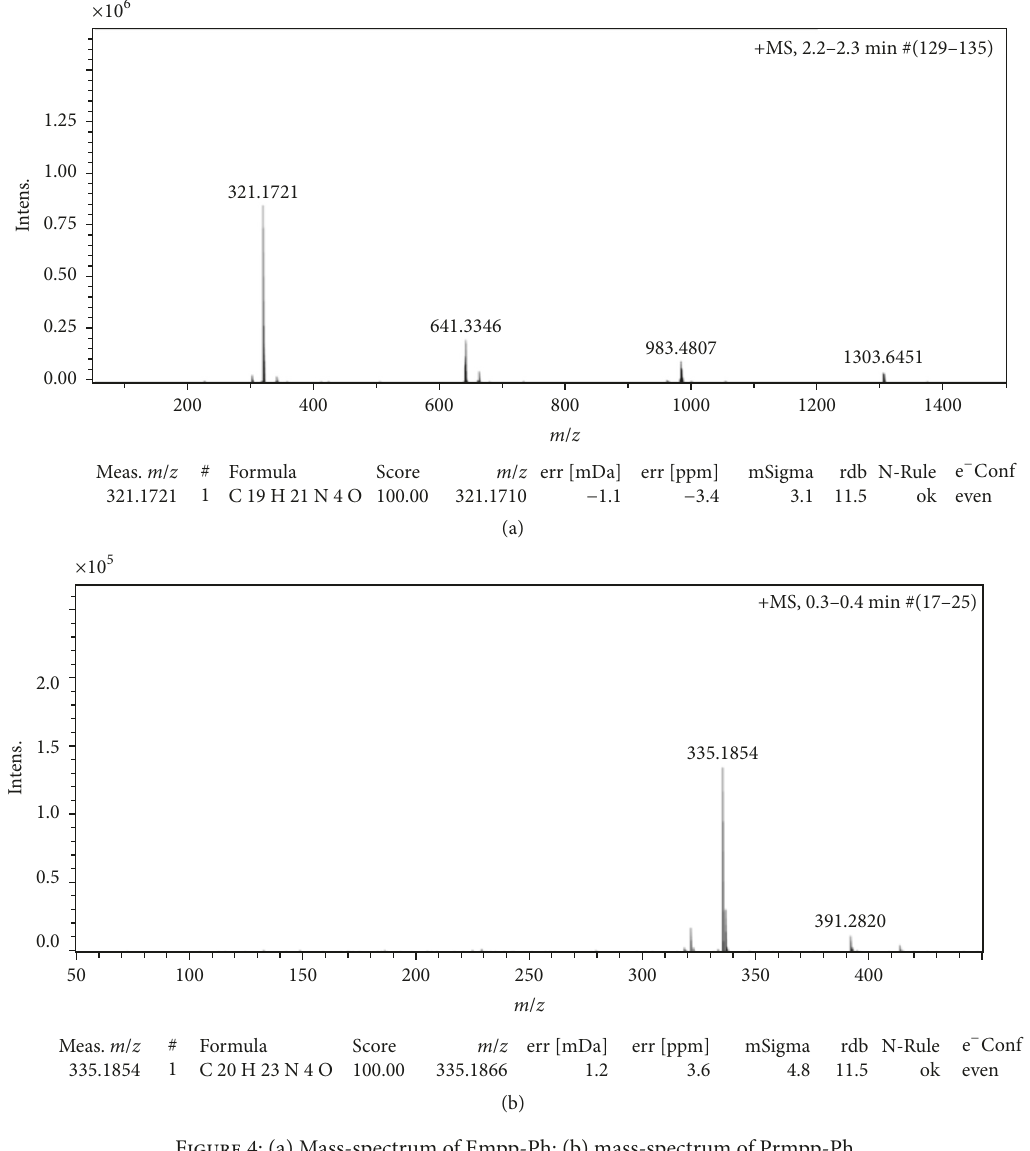
Figure 4: (a) Mass-spectrum of Empp-Ph; (b) mass-spectrum of Prmpp-Ph.